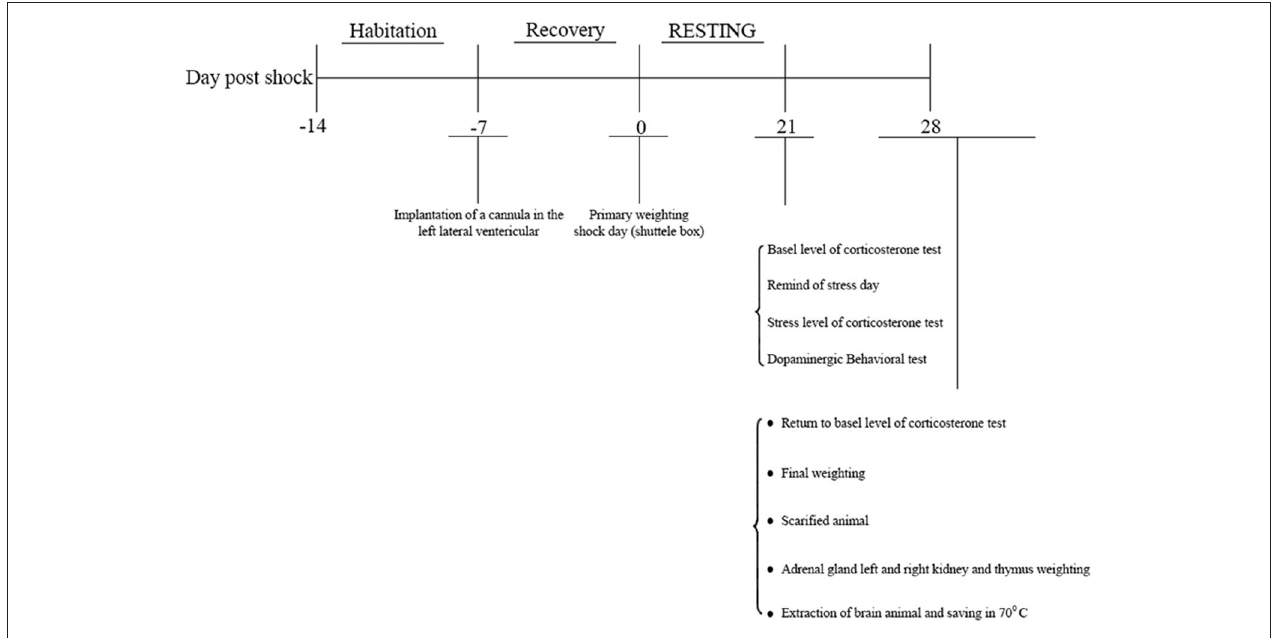
FIGURE 1 | Study protocol.